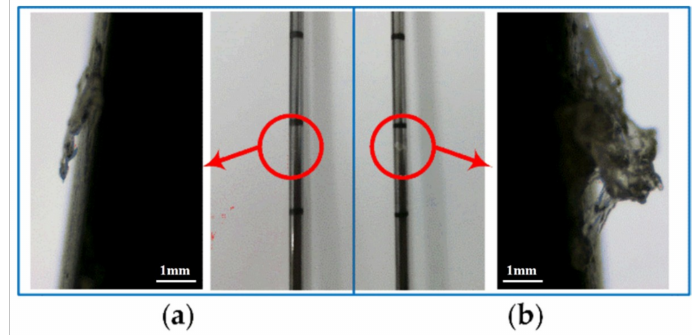
Figure 12. Microscopic image of the needle body surface: ( a ) coated needle; ( b ) uncoated